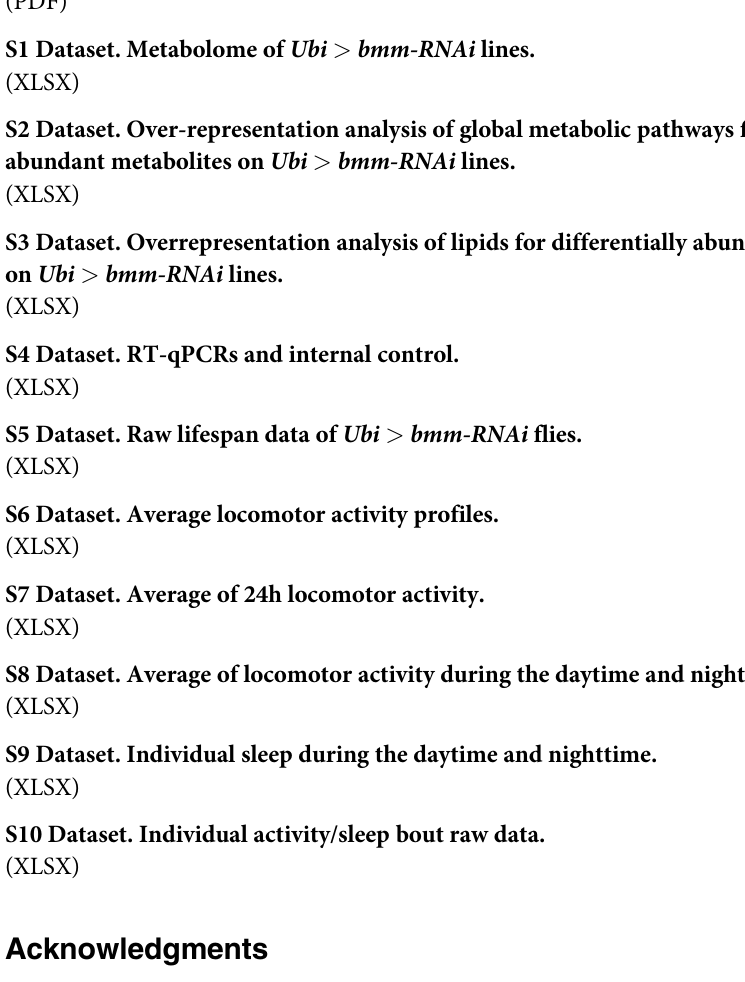
S5 Table. ANOVAs of sleep of bmm - RNAi lines expressed in fat-body ( Lsp2-Gal4 ) and oenocytes ( Dsat1-Gal4 and OK72-Gal4 ) in normal feeding. (PDF) S1 Dataset. Metabolome of Ubi > bmm-RNAi lines. (XLSX) S2 Dataset. Over-representation analysis of global metabolic pathways for differentially abundant metabolites on Ubi > bmm-RNAi lines. (XLSX) S3 Dataset. Overrepresentation analysis of lipids for differentially abundant metabolites on Ubi > bmm-RNAi